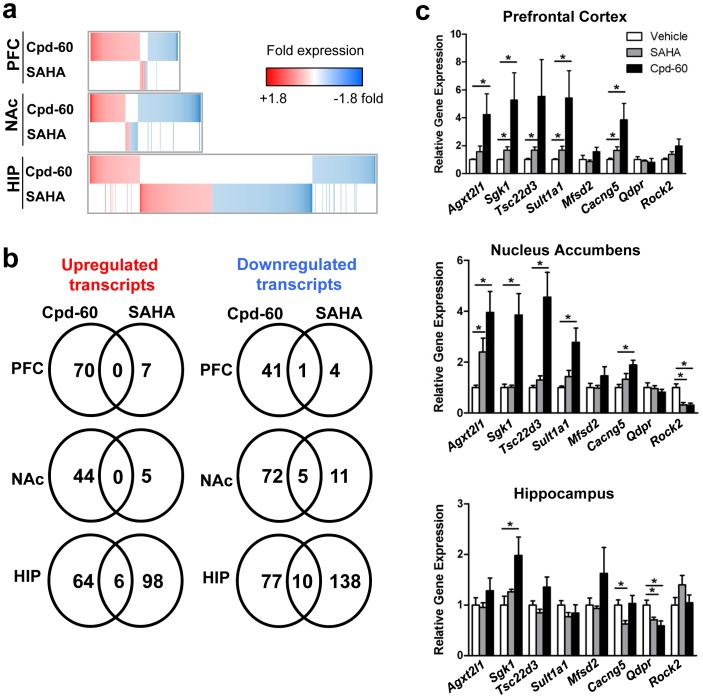
Gene expression changes in mouse brain following chronic HDAC inhibitor treatment.(a) Heatmaps illustrating transcript expression changes in mouse brain following chronic HDAC inhibitor treatment for 10 days. Cpd-60 (45 mg/kg, i.p.) significantly upregulated (red) or downregulated (blue) a similar number of transcripts in prefrontal cortex (PFC), nucleus accumbens (NAc), and hippocampus (HIP). Expression changes following SAHA treatment (25 mg/kg, i.p.) were predominantly localized to HIP. (b) Venn diagrams illustrate that only 1–10 genes were similarly regulated by Cpd-60 and SAHA treatment depending on brain region. Genes included in heatmaps and Venn diagrams have ≥1.2-fold expression change compared to vehicle (ANOVA p<0.05 with Tukey’s HSD post hoc test). (c) qPCR validation of a subset of genes with significantly altered expression following Cpd-60 treatment as determined by microarray analysis. *p<0.05, t-test of Cpd-60 or SAHA compared to vehicle.